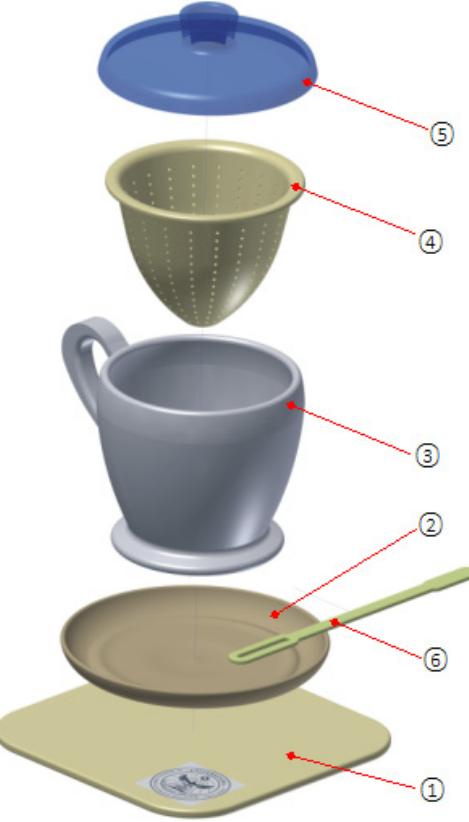
Figure 9. Exploded set: children’s toy set—teacup. (1) promo biscuit holder, (2) saucer, (3) teacup, (4) separator filter, (5) lid, (6) mixing spatula.